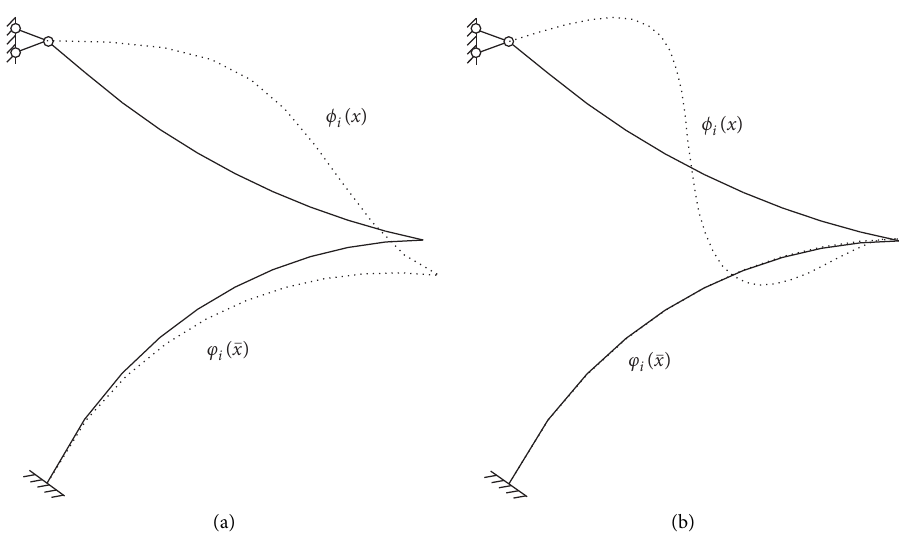
Figure 5: Modal shapes of the cable-stayed shallow arch: (a) global mode; (b) local mode.